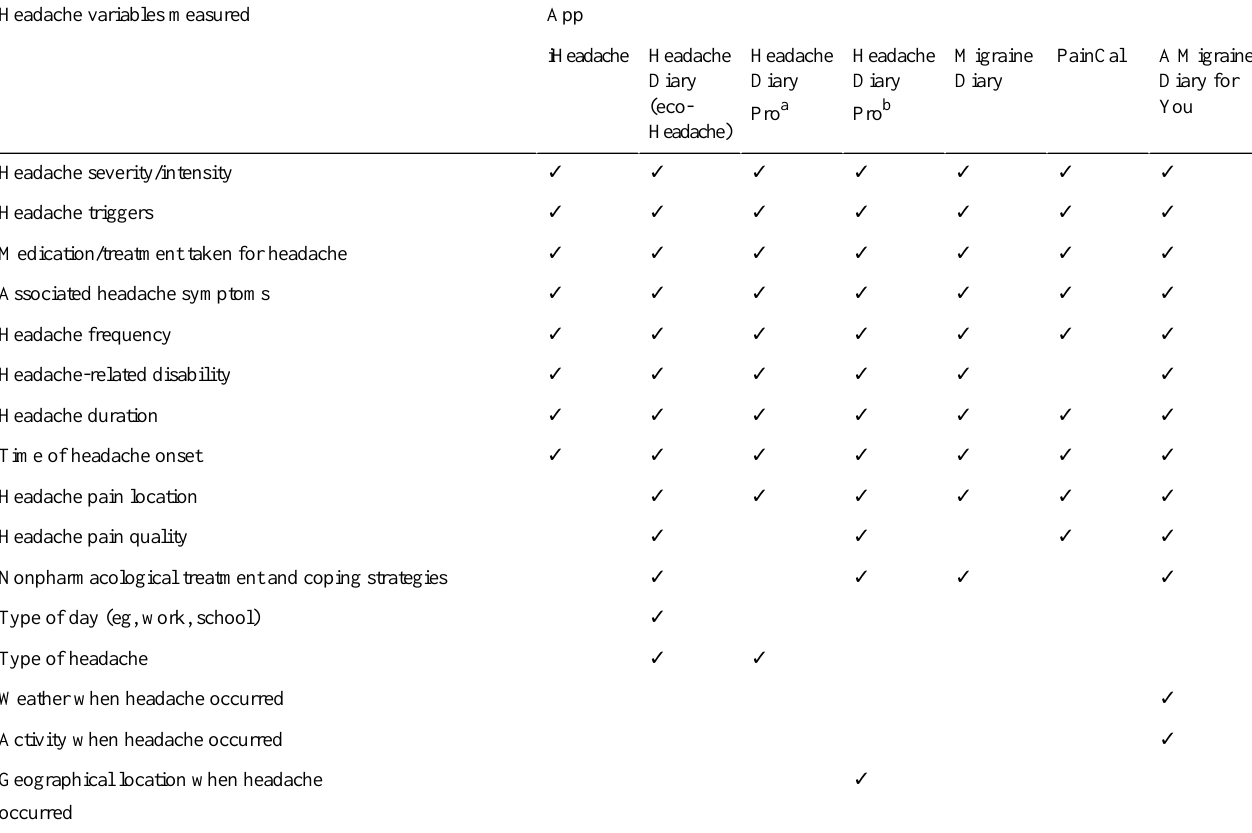
Table 5. Headache variables measured by all apps (n=7) meeting 4 or more app